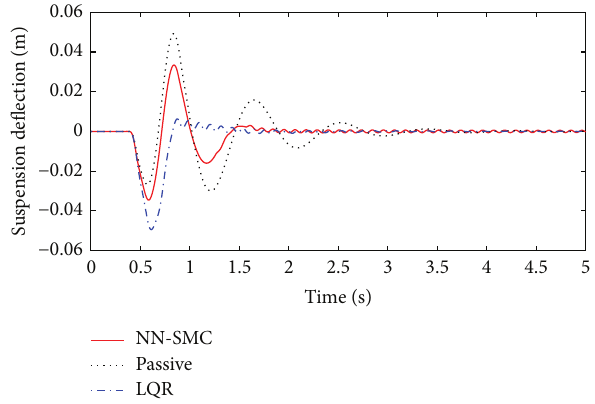
Figure 10: Suspension deflection (Case 2).